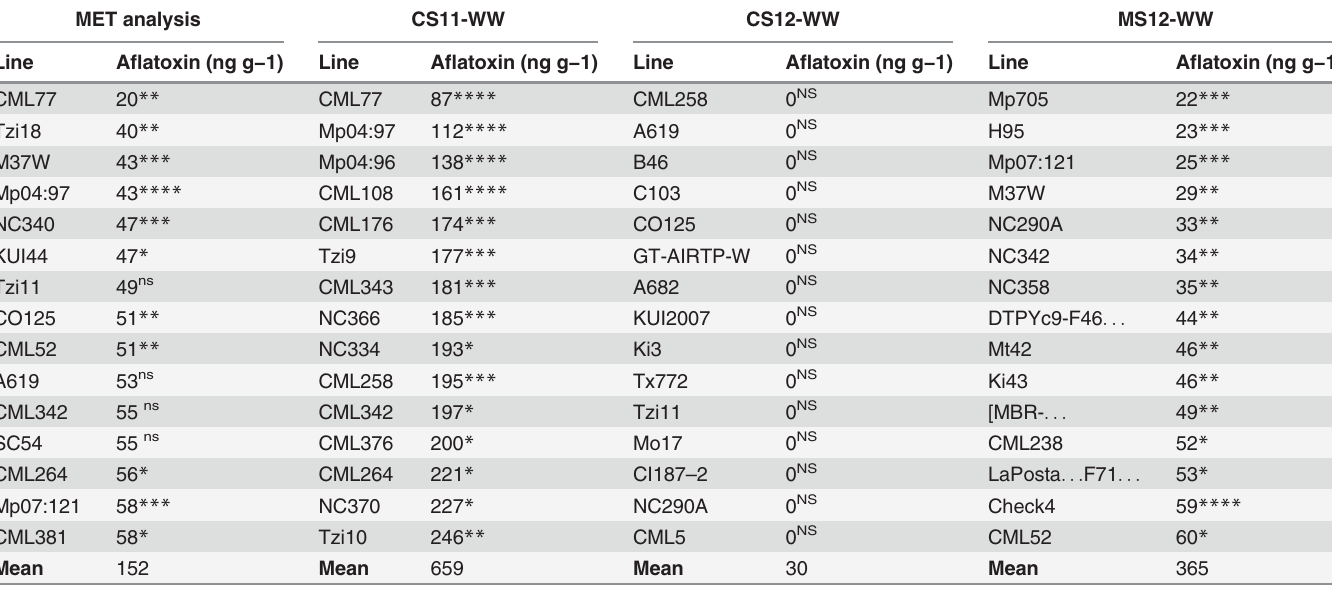
Table 7. BLUPs for the 15 lowest a fl atoxin accumulating hybrids for all the trials and the MET analysis. MET